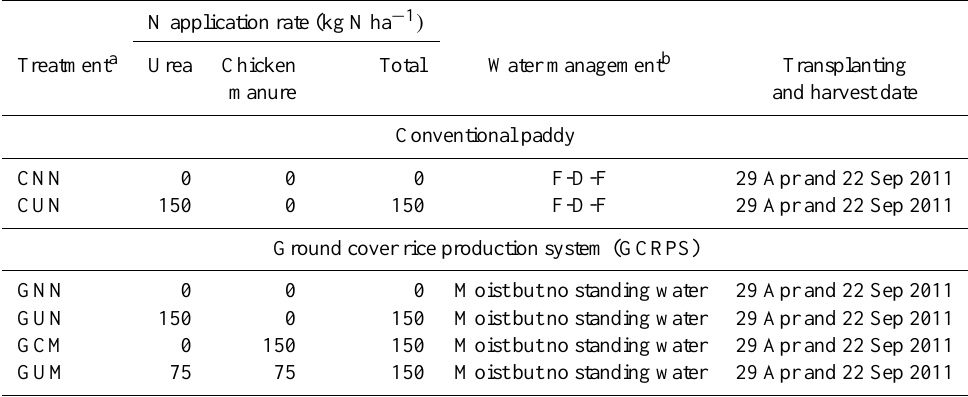
Table 1. Field management practices for different fertilizer treatments in the conventional paddy and ground cover rice production systems over the rice-growing season of